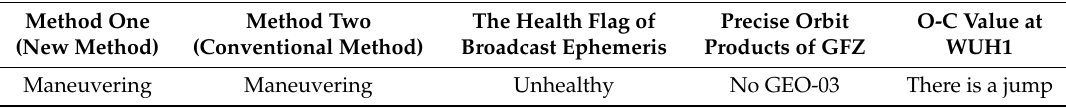
Table 1. Results of GEO-03 maneuvering detection at 14:00–15:00.